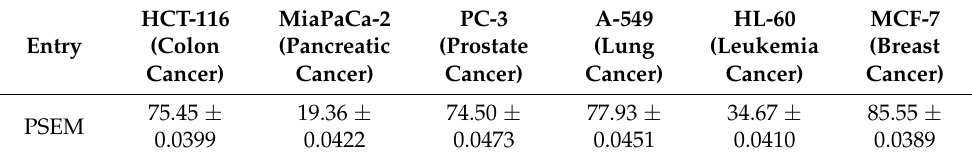
Table 4. Percentage inhibition of cancer cells by different extracts of E. microphylla at 50 µ g/mL.